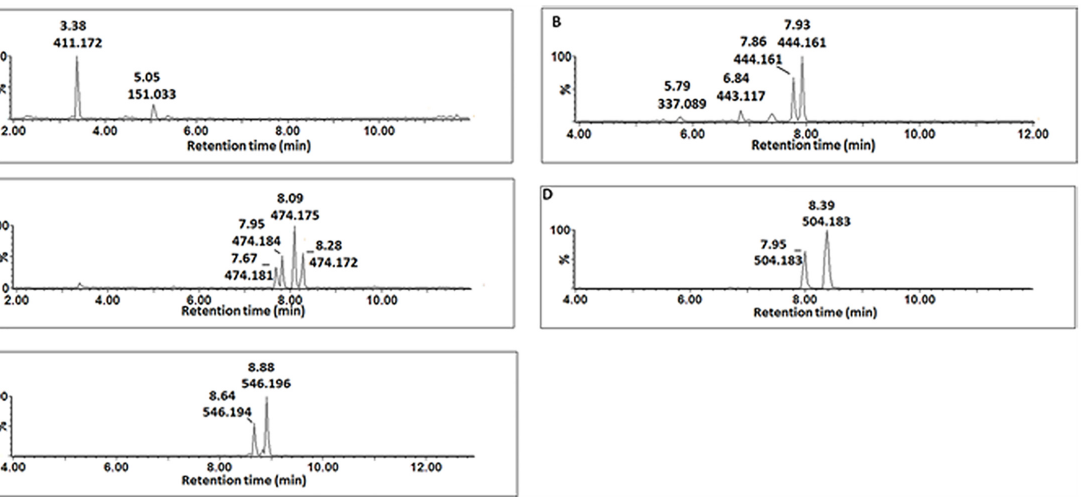
Fig 5. Single ion chromatograms (XIC) of UHPLC-MS/MS showing the retention times of cinnamic acid derivatives conjugated to nitrogen containing molecules. Caffeoylputrescine glycoside (A) , p -coumaroyltyramine glycoside (B) , feruloyltyramine glycoside (C) , feruloyl-3-methoxytyramine- 4-glycoside (D) and feruloyl-3-methoxytyramine conjugate (E).